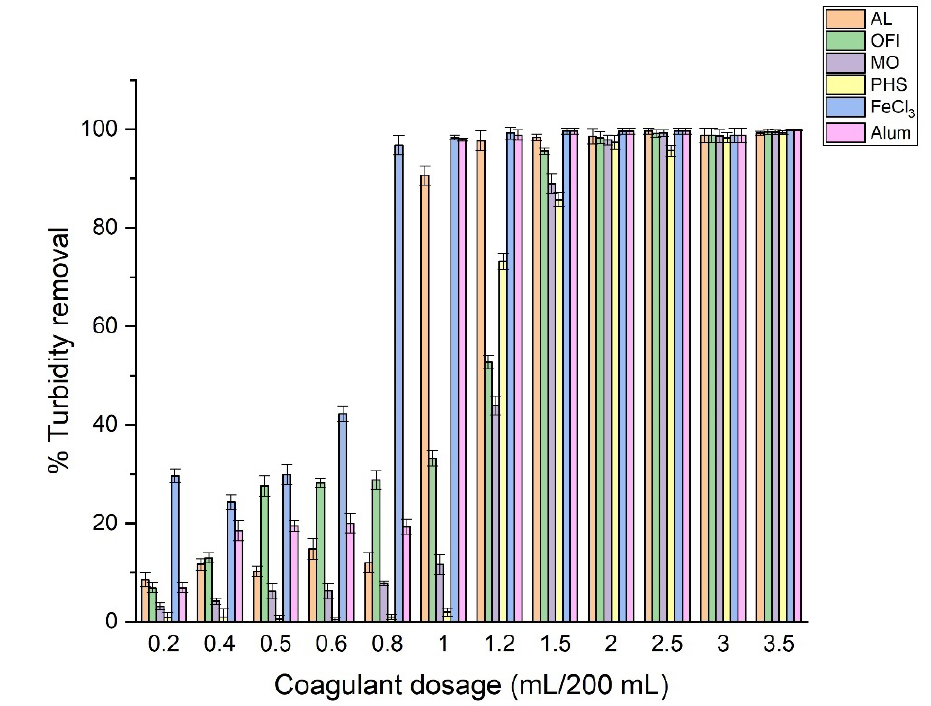
Figure 5. Effect of coagulant dosage on turbidity removal. Figure 5 . Effect of coagulant dosage on turbidity removal.